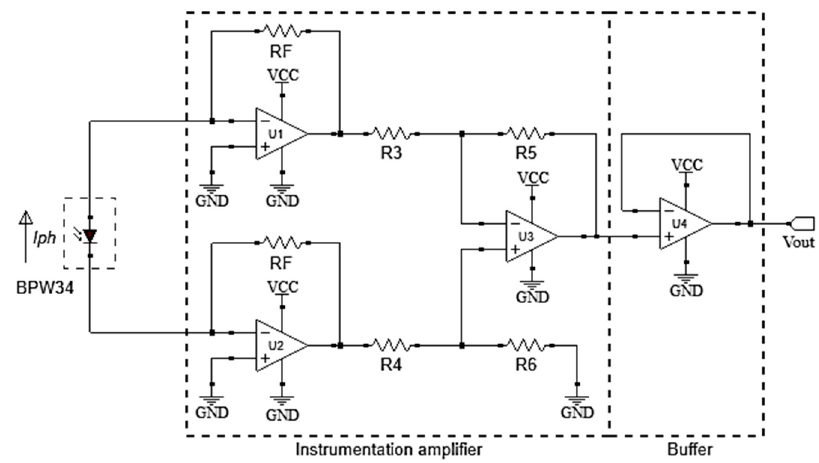
Figure 4. Architecture of the signal conditioning circuit.